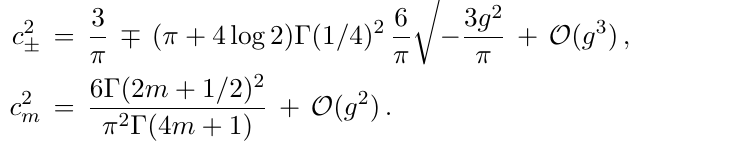
Figure 5 . Plots of k ( h ) the result strictly at d = 2 and the orange lines represent the (cid:12)rst order correction of (cid:15) the plots, we took (cid:15) = 0 : 1. The green lines are the results with the zeroth and (cid:12)rst order corrections